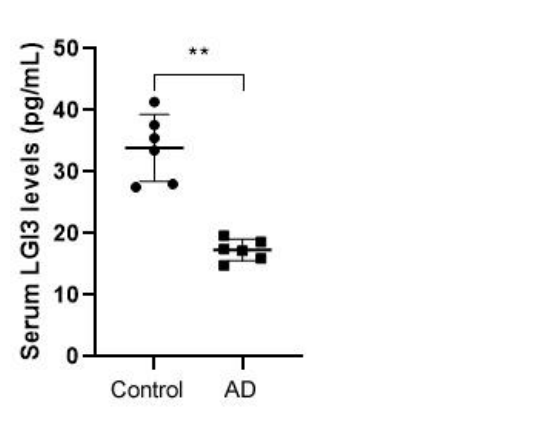
Figure 1. Comparison of leucine-rich glioma inactivated 3 (LGI3) concentration in serum of both the control and atopic dermatitis (AD) group (n = 6). The concentration was significantly reduced in the AD group compared with the control group. Data are expressed as mean ± S.D. (** P < 0.01 vs. control group). Di ff erences between control and AD model group were estimated by